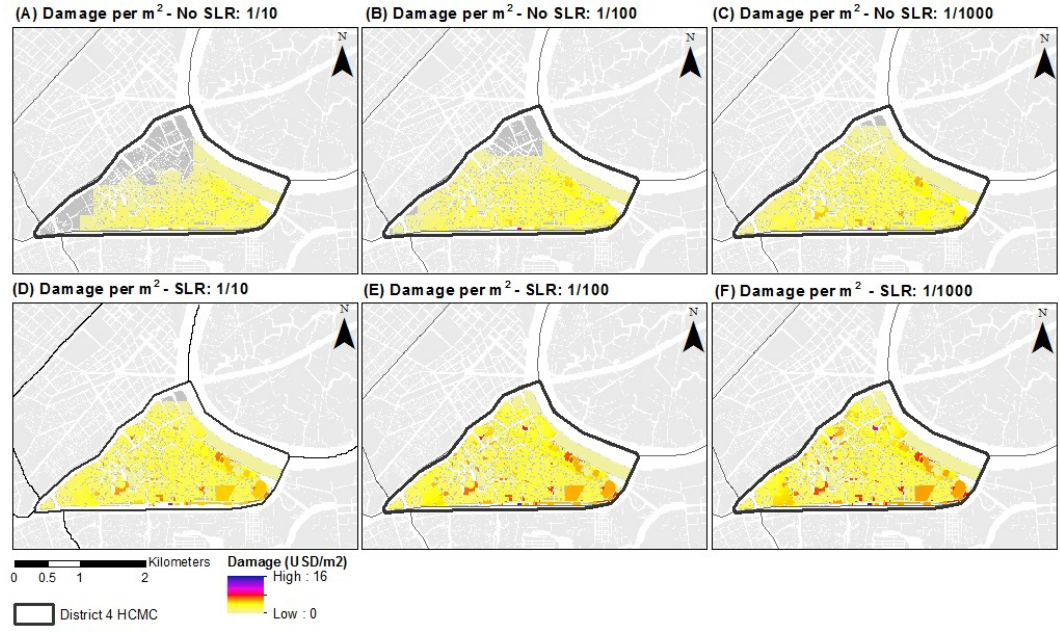
Figure 6. Damage occurring for floods with different return periods, the top figures ( A , B and C ) result from using the baseline sea-level scenario, and the bottom figures ( D , E , and F ) result from using the sea-level rise scenario.